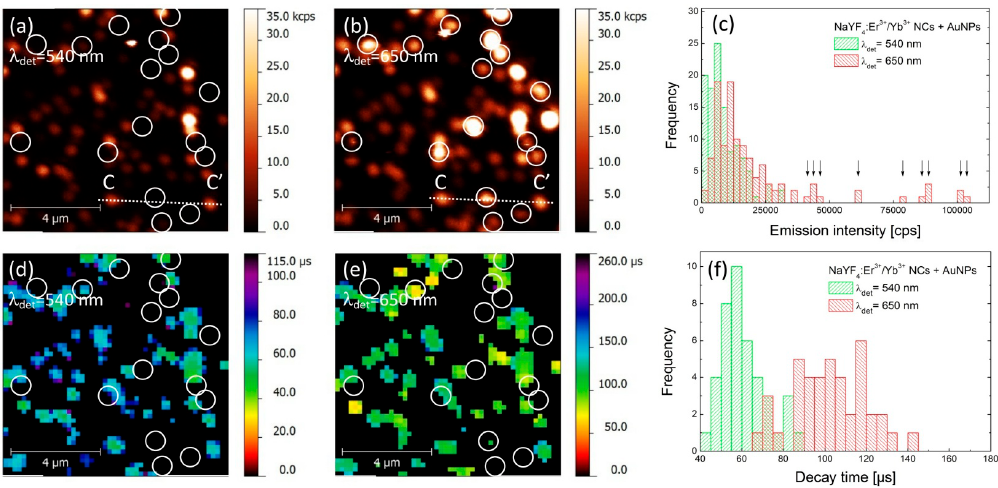
Figure 3. Photoluminescence intensity maps of α -NaYF 4 :Er 3+ /Yb 3+ nanocrystals deposited on gold nanospheres observed at 540 nm ( a ) and 650 nm ( b ). Circles indicate position of the NCs which are quenched in the green channel but remain active in the red detection channel. Statistical distributions of the luminescence intensities are presented in section ( c ), where arrows denote emission from the NCs quenched in the green channel. FLIM images of green and red emissions are presents in sections ( d , e ), respectively, together with statistical distributions of decay times in section ( f ).